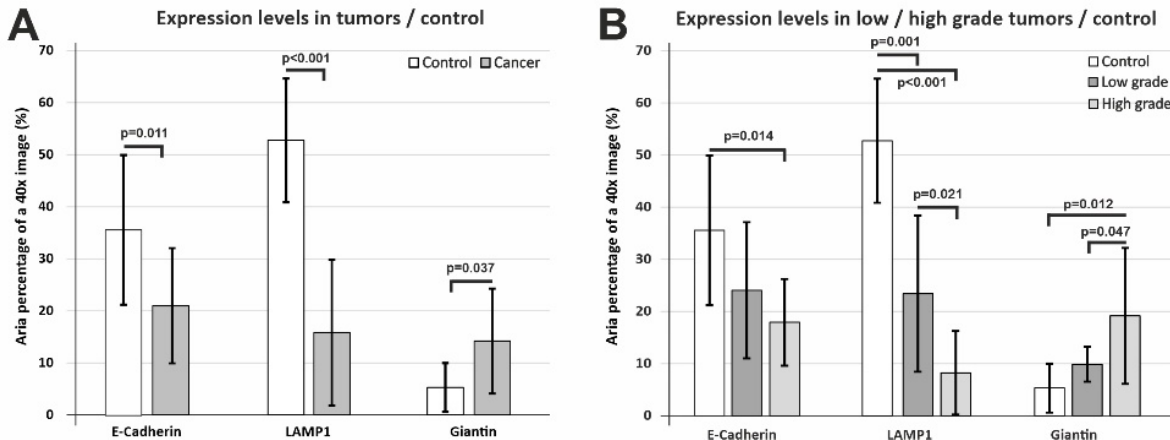
Figure 7. Area expression levels of E-cadherin, LAMP1 and Giantin in control and tumor epithelia. ( A ) E-cadherin and LAMP1 show overall significant decrease compared to control tissue, while Giantin exhibits a significant increase in tumor epithelia compared to the control. ( B ) Further stratification into low-grade/high-grade tumors showed that E-cadherin and LAMP1 decreased with increasing tumor anaplasia, while Giantin showed a massive increase for high-grade tumors. Significance is shown for Student’s t-test ( A ) or using a one-way ANOVA followed by a post hoc Fisher’s LSD test ( B ). Data are expressed as means ± SD.